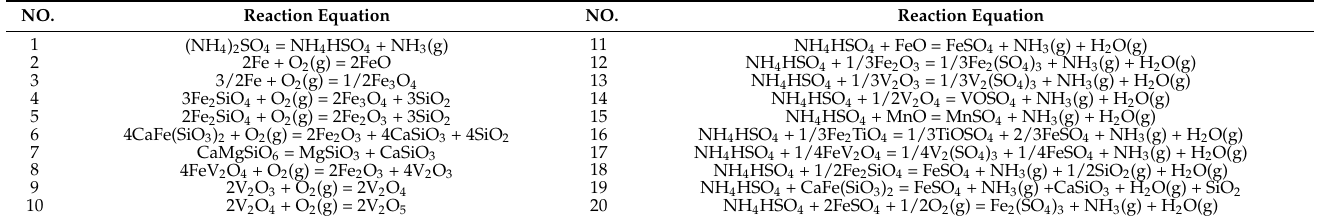
Table 1. Reactions occurred in (NH 4 ) 2 SO 4 roasting process.